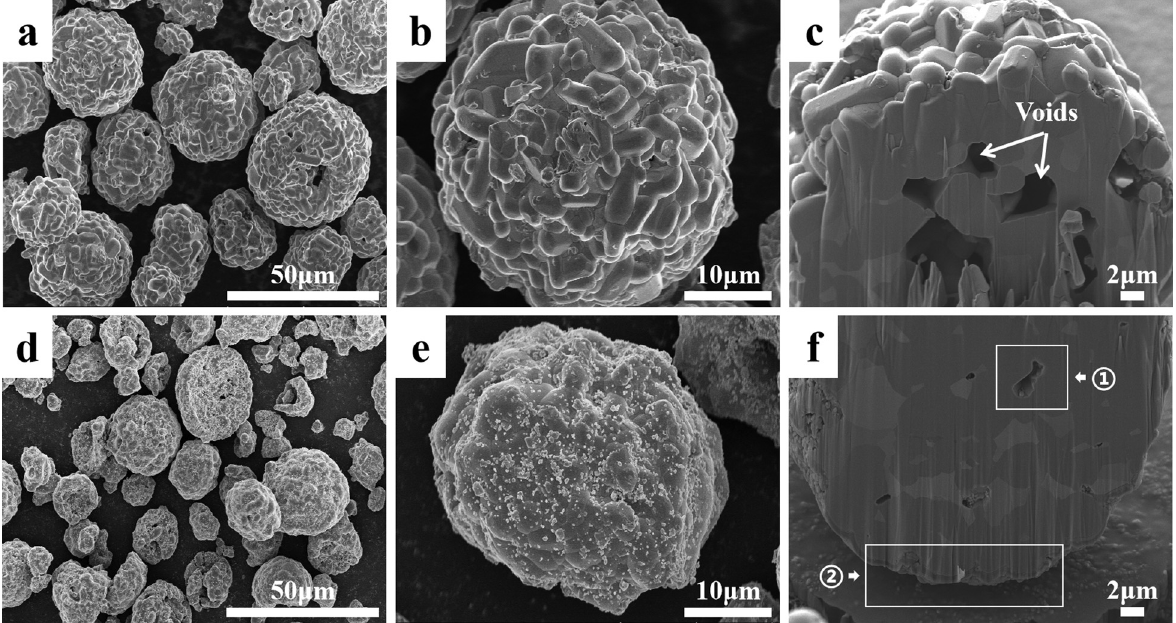
Figure 1: SEM images of Cr 3 C 2 – NiCr powders: ( a, b, c ) CP; ( d, e, f )